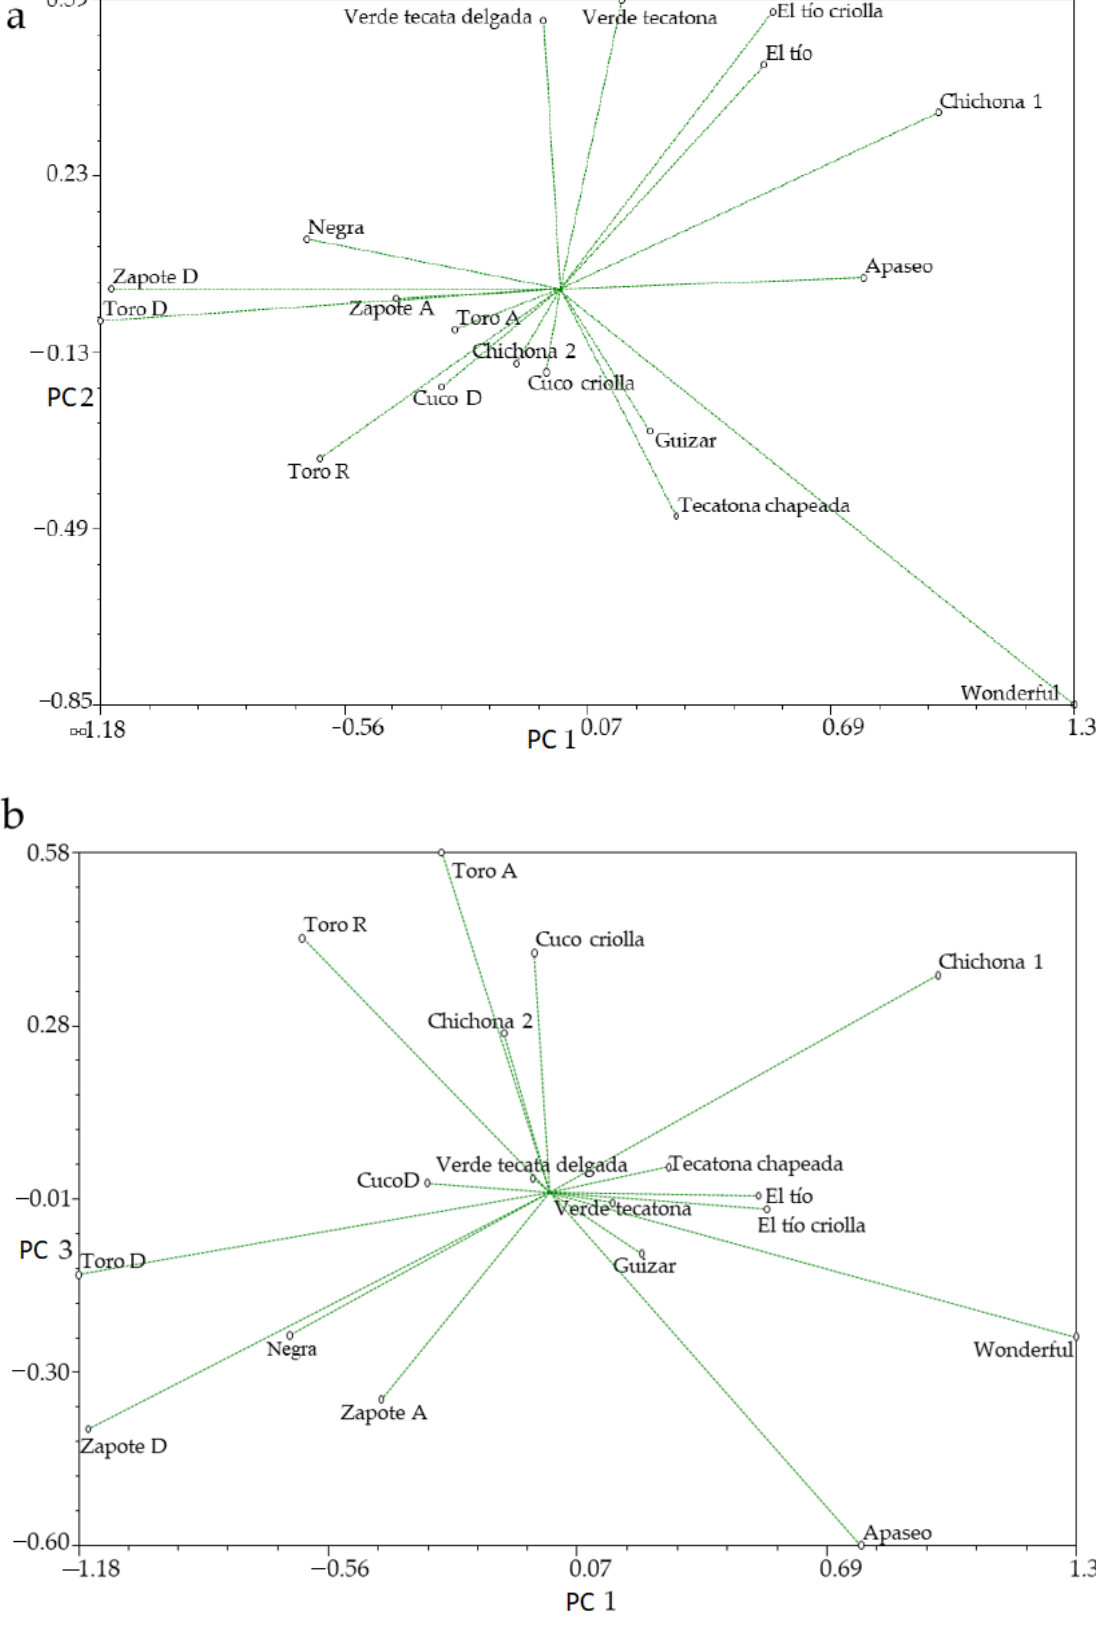
Figure 2. PCA distribution of 18 pomegranate genotypes: ( a ) PC1 vs. PC2, ( b ) PC1 vs. PC3. Based on fruit